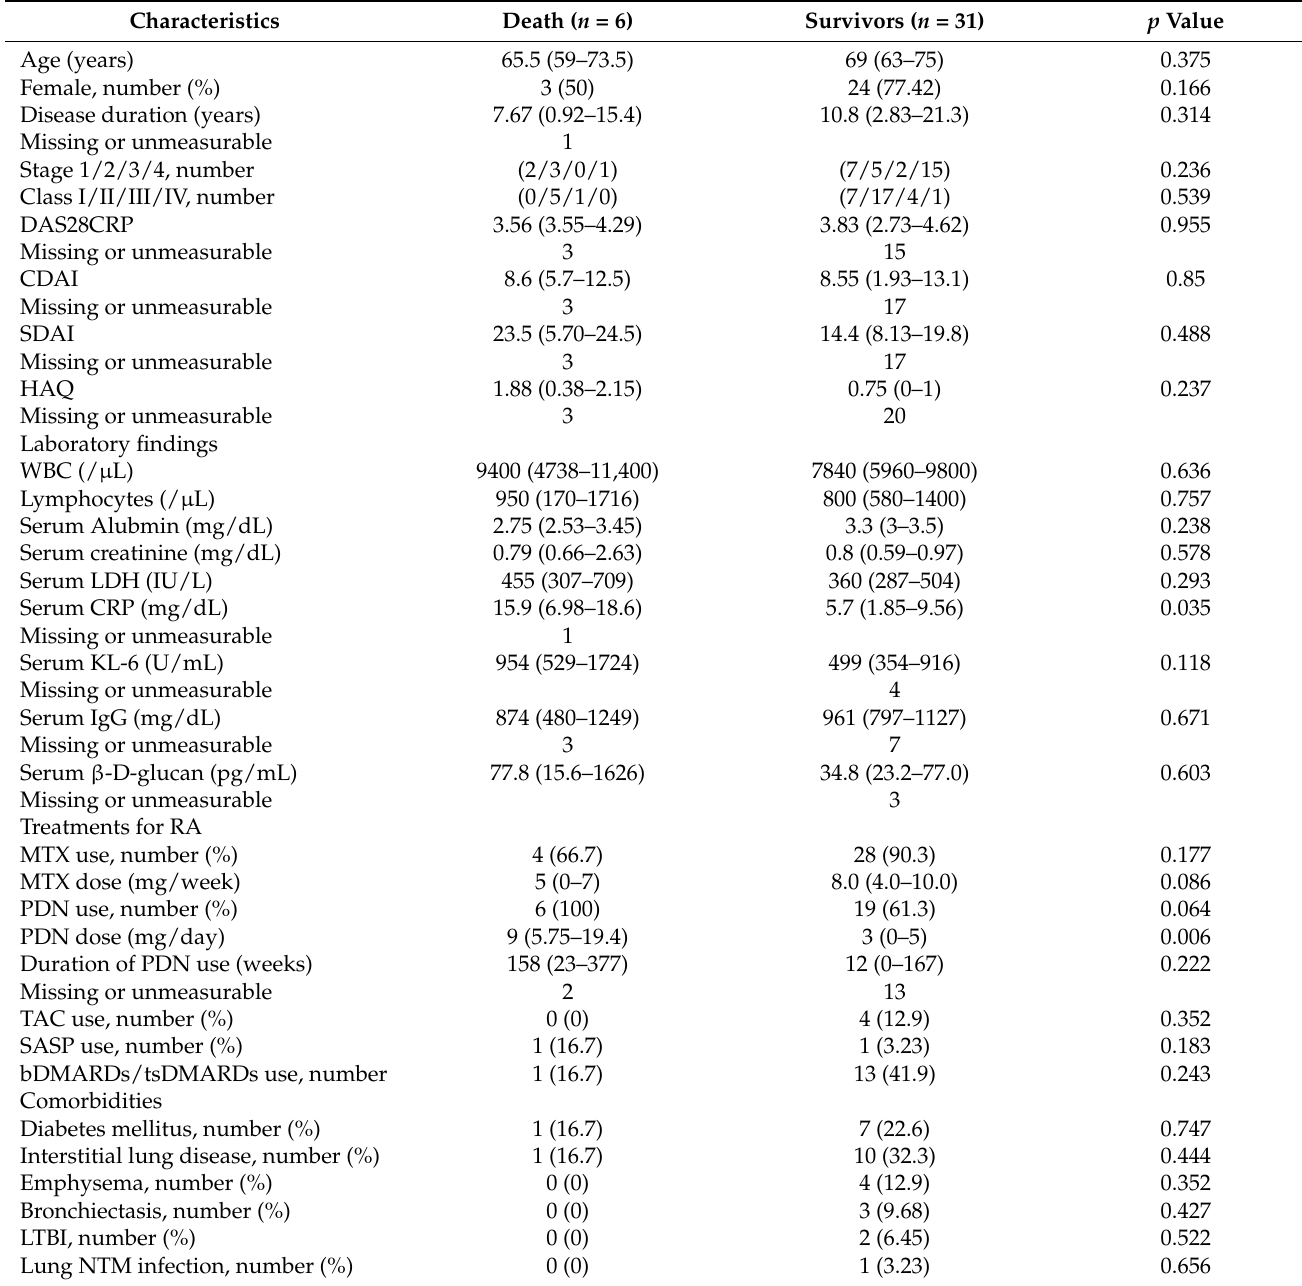
Table 3. Clinical characteristics at baseline between PCP death patients and survival